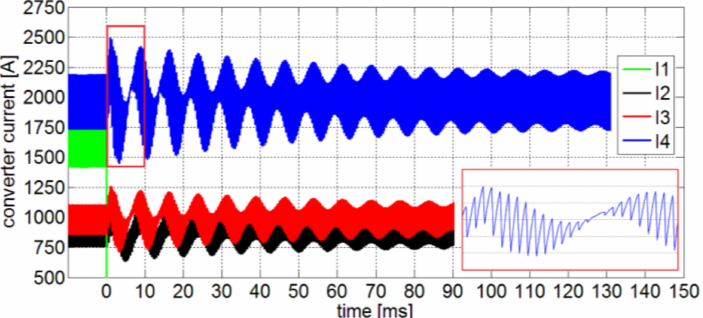
Figure 13. Converter currents transient in Case 3 (each Y-division is 250 A in zoomed graph).